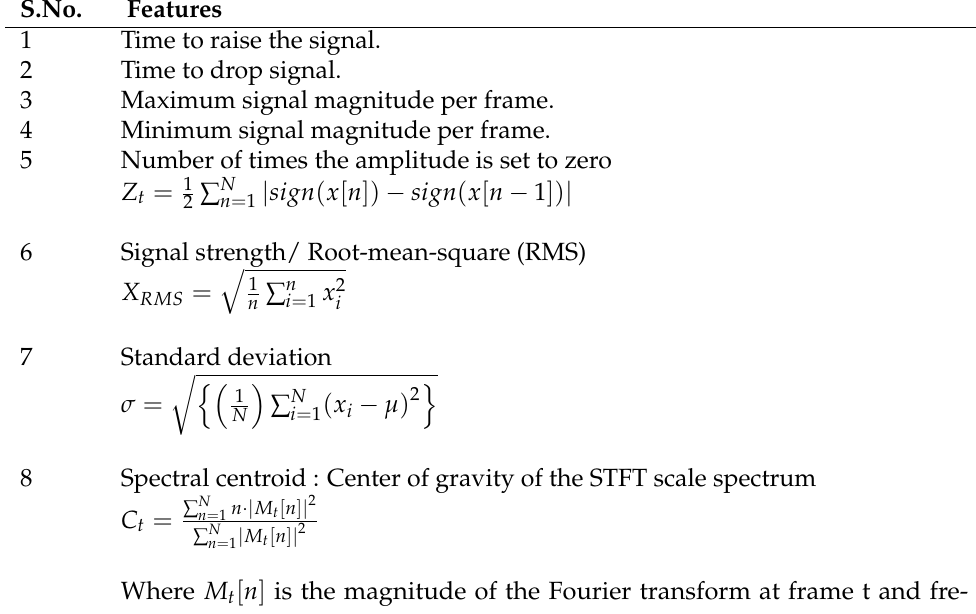
Table 1. List of features for accident detection.